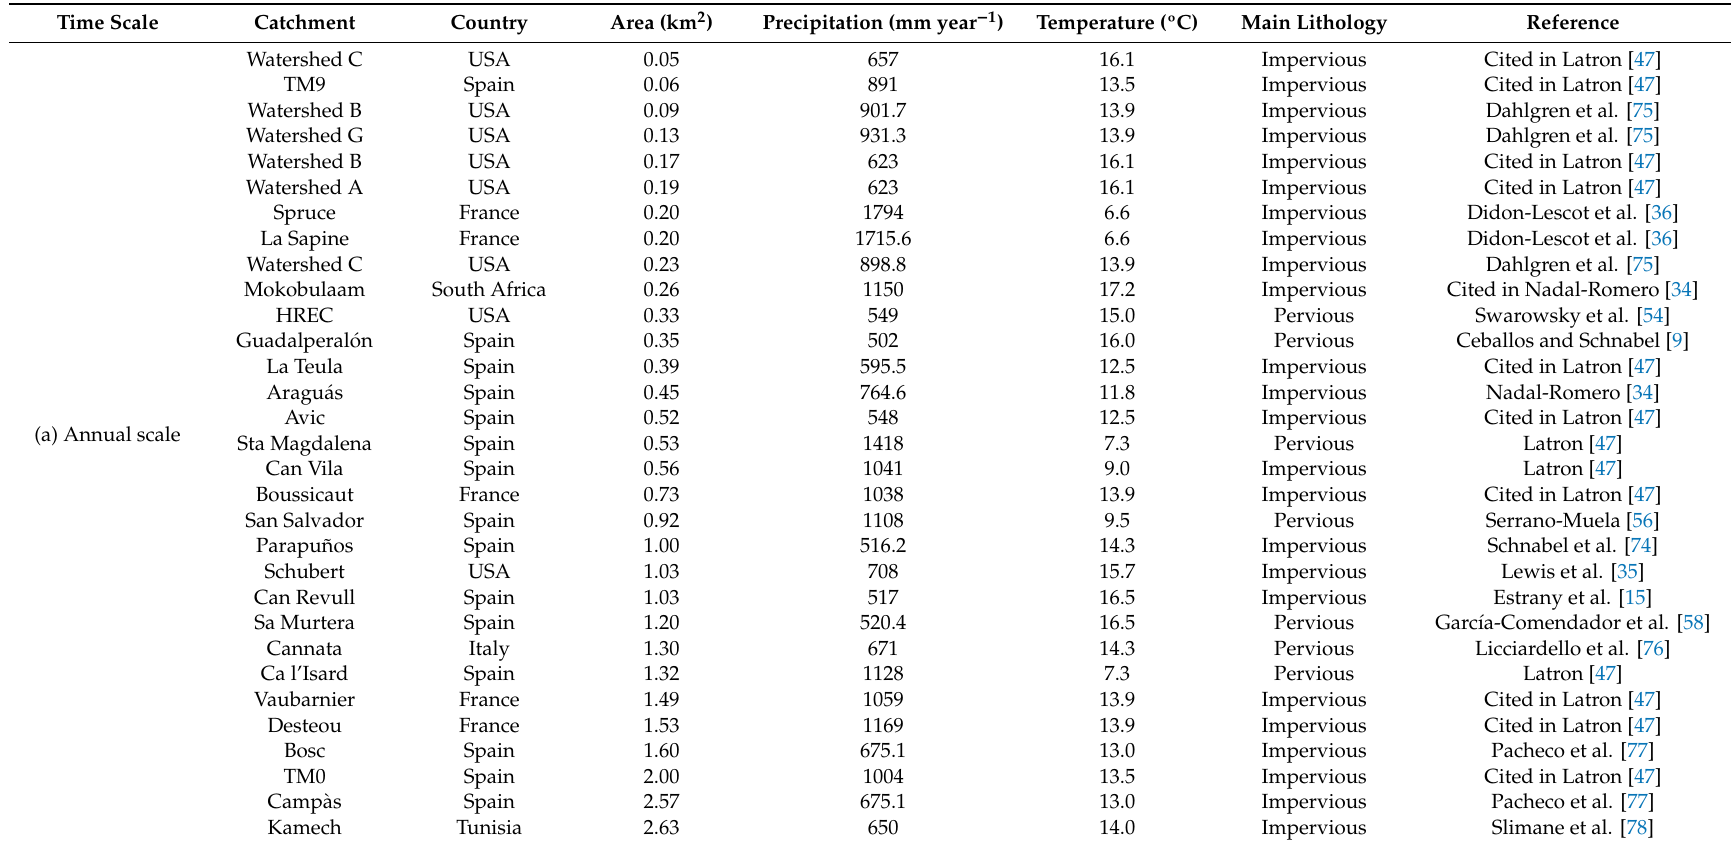
Table A1. Mediterranean studies used into the rainfall-runo ff relationship at ( a ) annual and ( b ) event